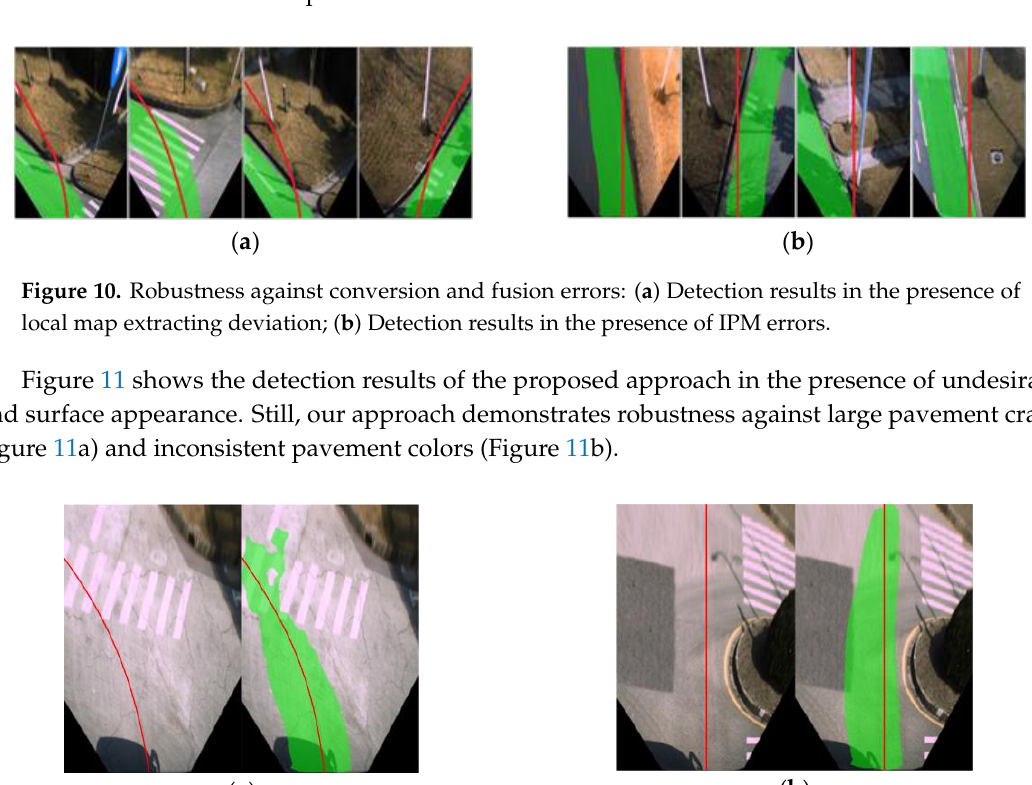
Figure 9. Robustness against illumination variation.